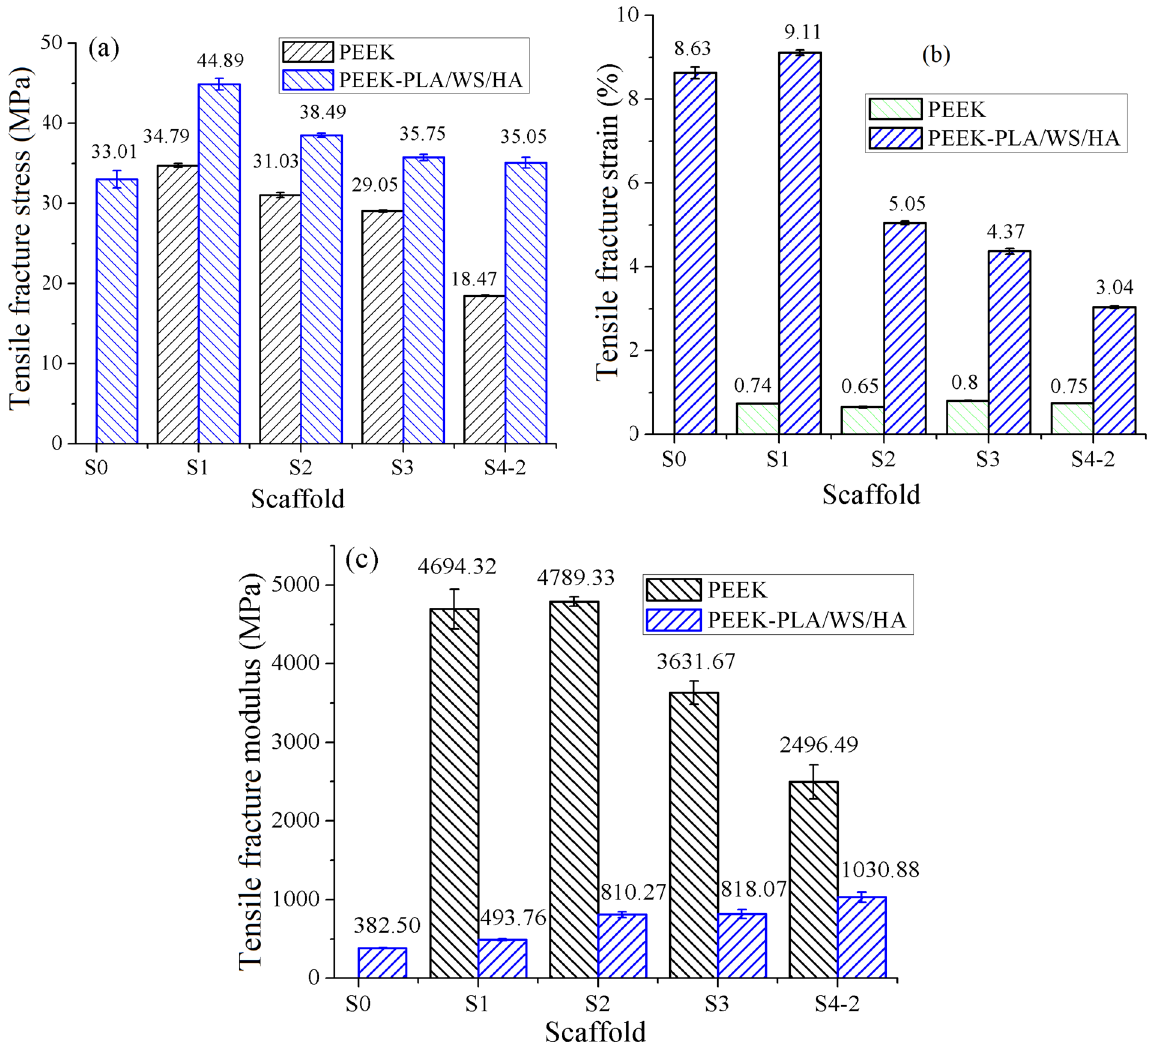
Figure 8. Tensile fracture properties of FFF PEEK scaffolds 26 and PEEK-PLA/WS/HA scaffolds: ( a ) stress, ( b ) strain and ( c )